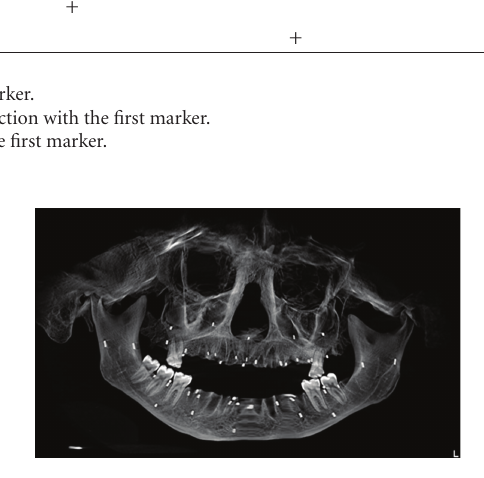
Figure 1: Panoramic view of the skull radiograph with 10 degree left tilt. Opaque gutta-percha markers are observed in the